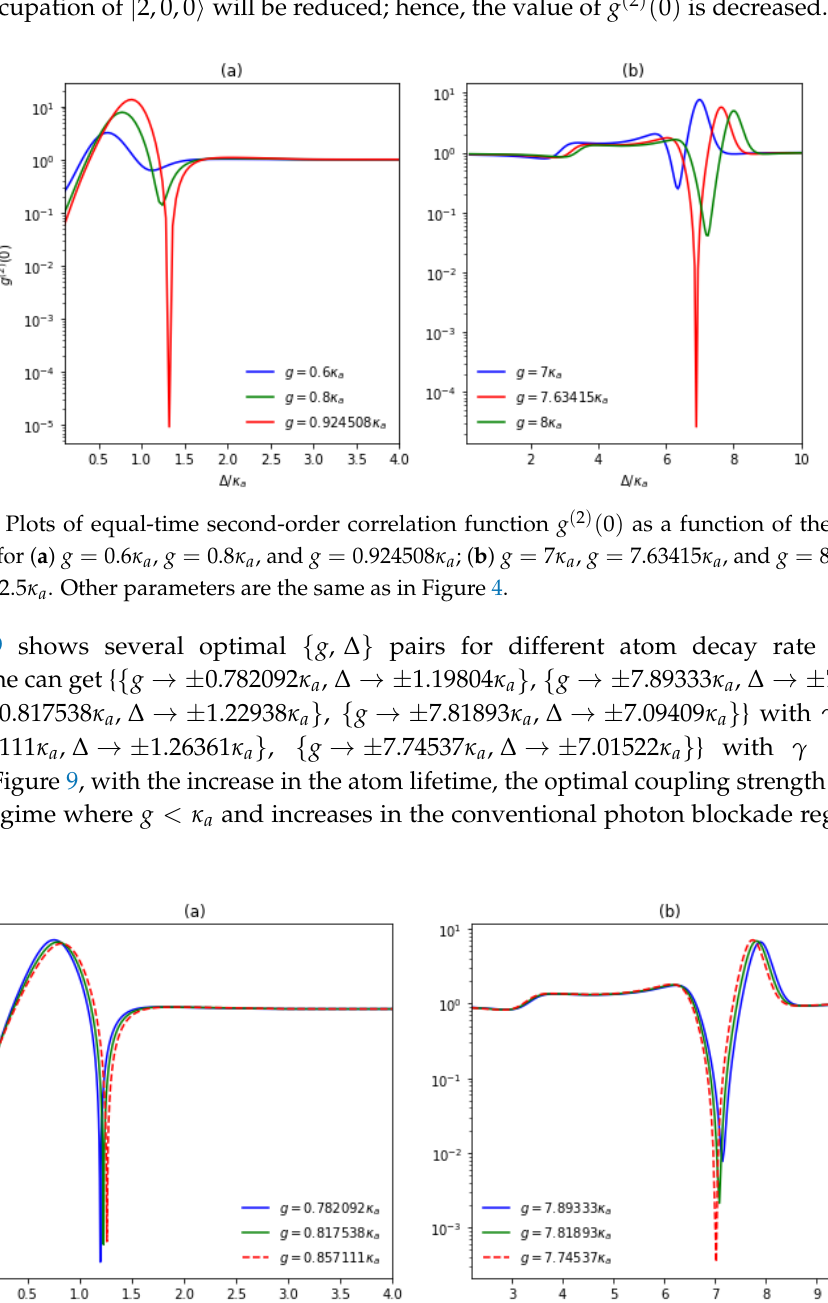
Figure 9. Plots of g ( 2 ) ( 0 ) versus the scaled detuning ∆ / κ a for ( a ) g < κ a ; ( b ) g > κ a with γ = 0.25 κ a ,   for ( a ) g   ; ( b ) g   with Figure 9. Plots of (2) (0) g versus the scaled detuning / a a a γ = 0.35 κ a , and γ = 0.45 κ a . Other parameters are the same as in Figure =0.25   , 0.35    , and 0.45    . Other parameters are the same as in Figure 8. a a a